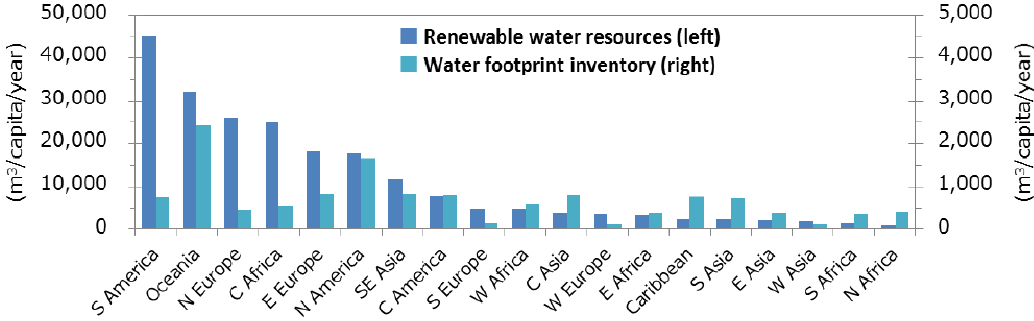
Figure 5. Renewable water resources and water footprint inventory per capita by region.